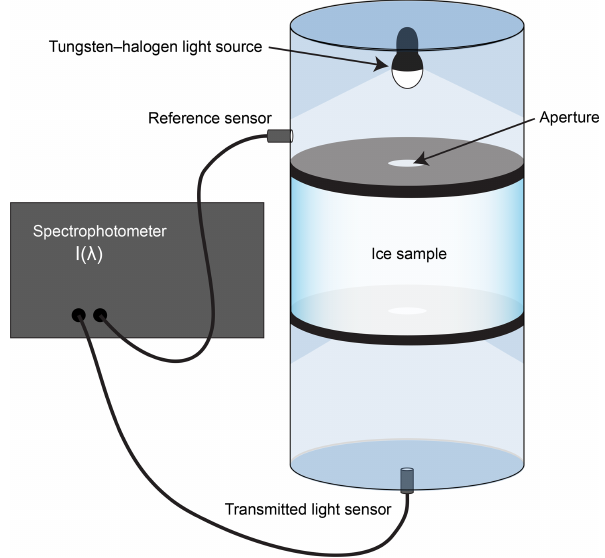
Figure 4. Schematic depicting laboratory setup for measuring light transmittance through 10cm tall ice core samples. Adapted from Light et al.